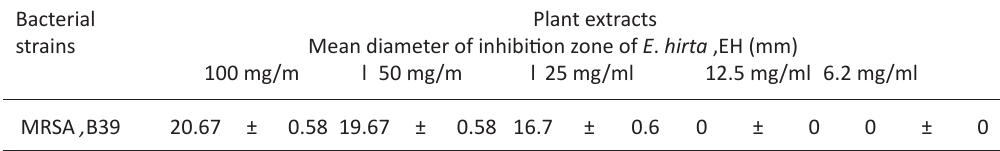
Table 3 . Effect of different solvents of plant extracts of P. plebeium , PP and E. hirta , EH on the selected pathogenic bacterial strain under study Plant extracts